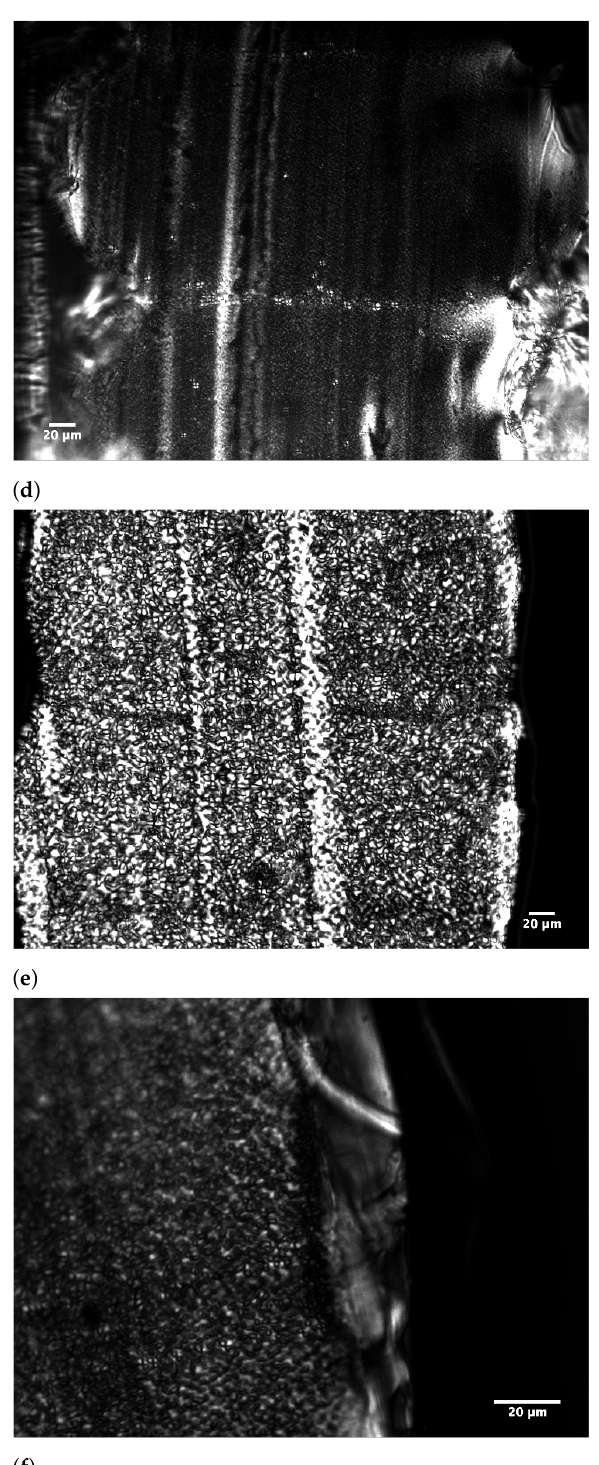
Figure 11. Examples of PLM images depicting the variations in crystalline morphology and spherulite sizes obtained across the distinct printing conditions after FFF